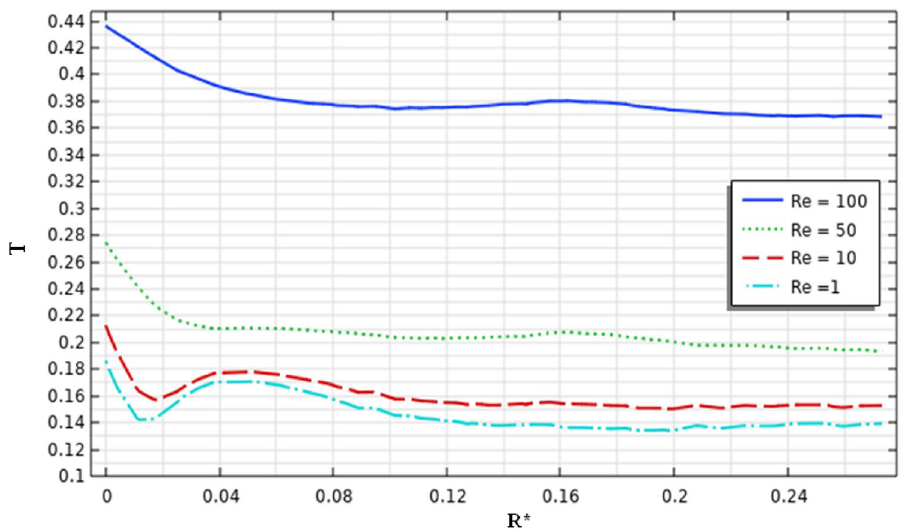
Figure 15. Temperature distribution on the vertical axis of the